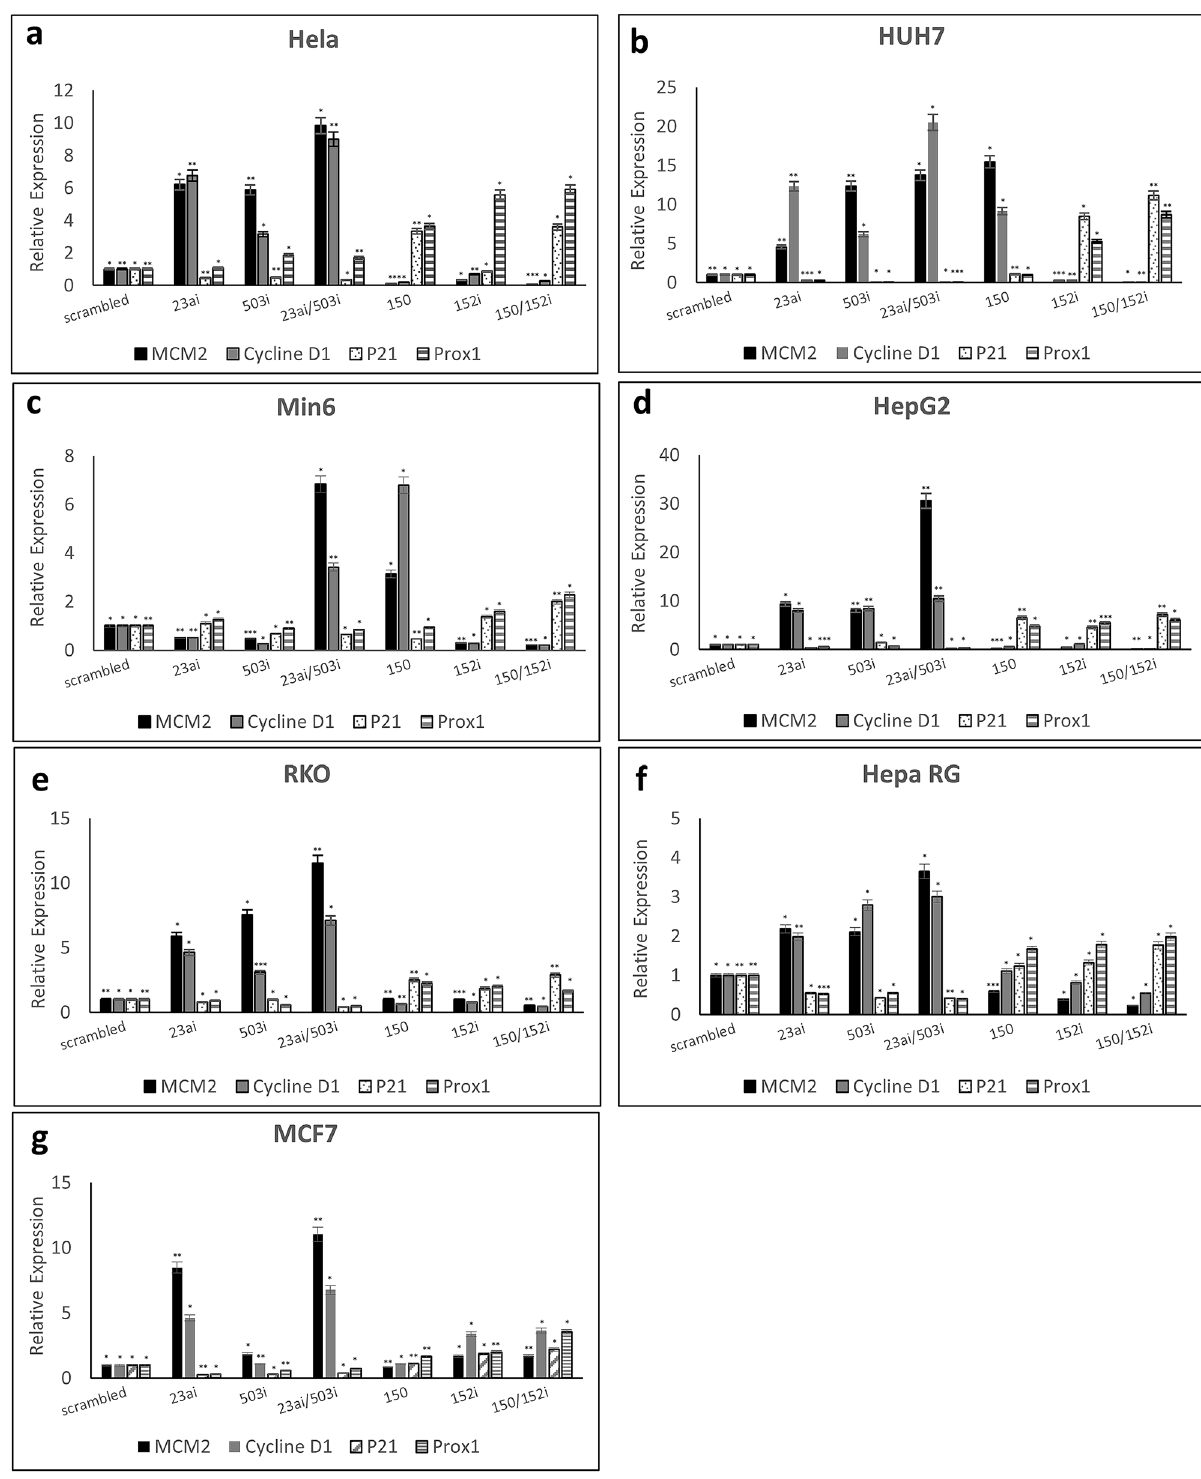
Figure 2. qPCR analysis of regulators of cell proliferation: MCM-2, Cyclin D1, p21 and Prox1. RNA templates were made from ( a ) Hela, ( b ) HUH7, ( c ) Min6, ( d ) HepG2, ( e ) RKO, ( f ) HepaRG and ( g ) MCF7 cells transfected with scrambled, miRNA-23i, miRNA-503i, miRNA-23ai/-503i, miRNA-150, miRNA-152i and miRNA-150/-152i. All expression levels were normalized to scrambled control vector. qPCR data in all cases are representative of three different experiments. Error bars indicate